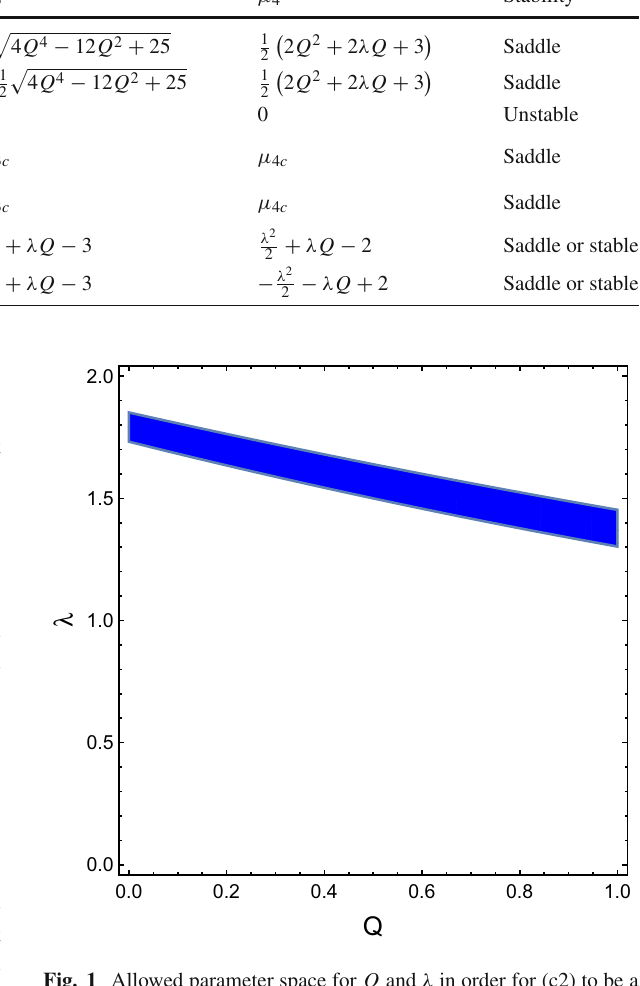
Table 2 Eigenvalues and stability of the fixed points Point